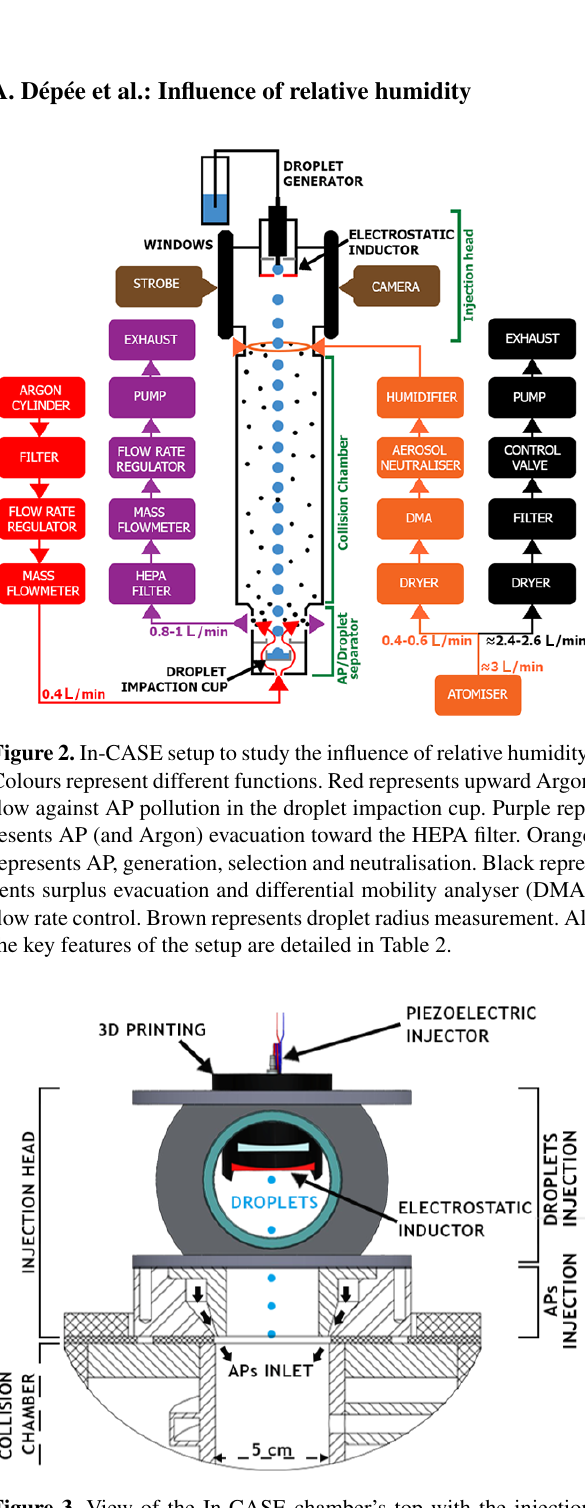
Figure 3. View of the In-CASE chamber’s top with the injection head where APs and droplets are injected into the collision chamber.